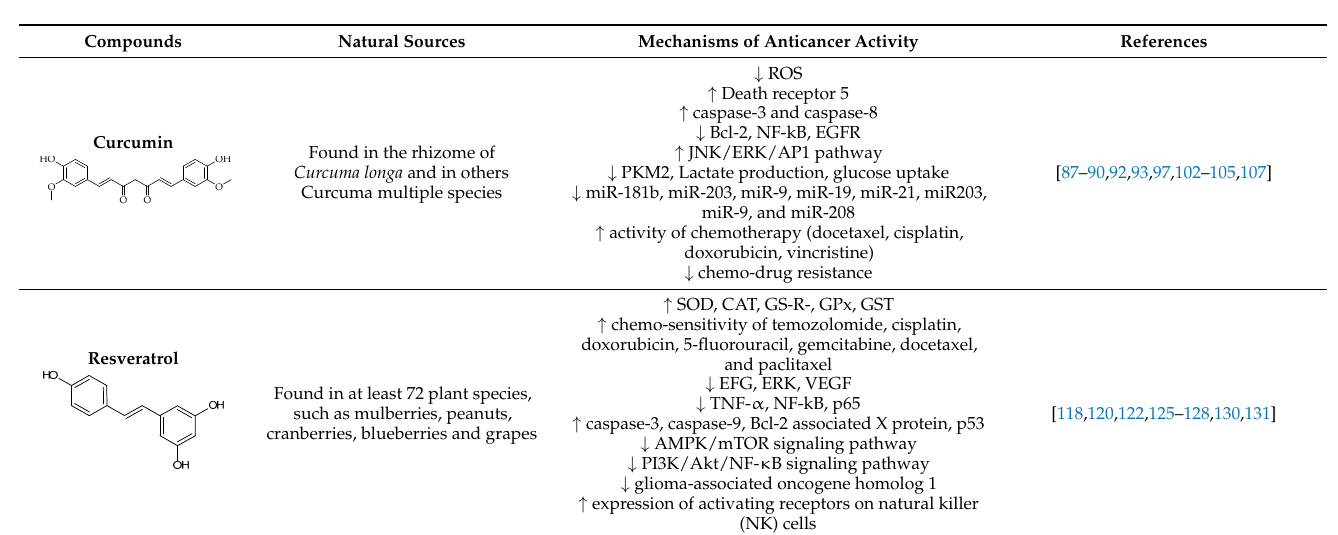
Table 1. Plant-derived compounds with their main natural sources and anticancer mechanisms of action.